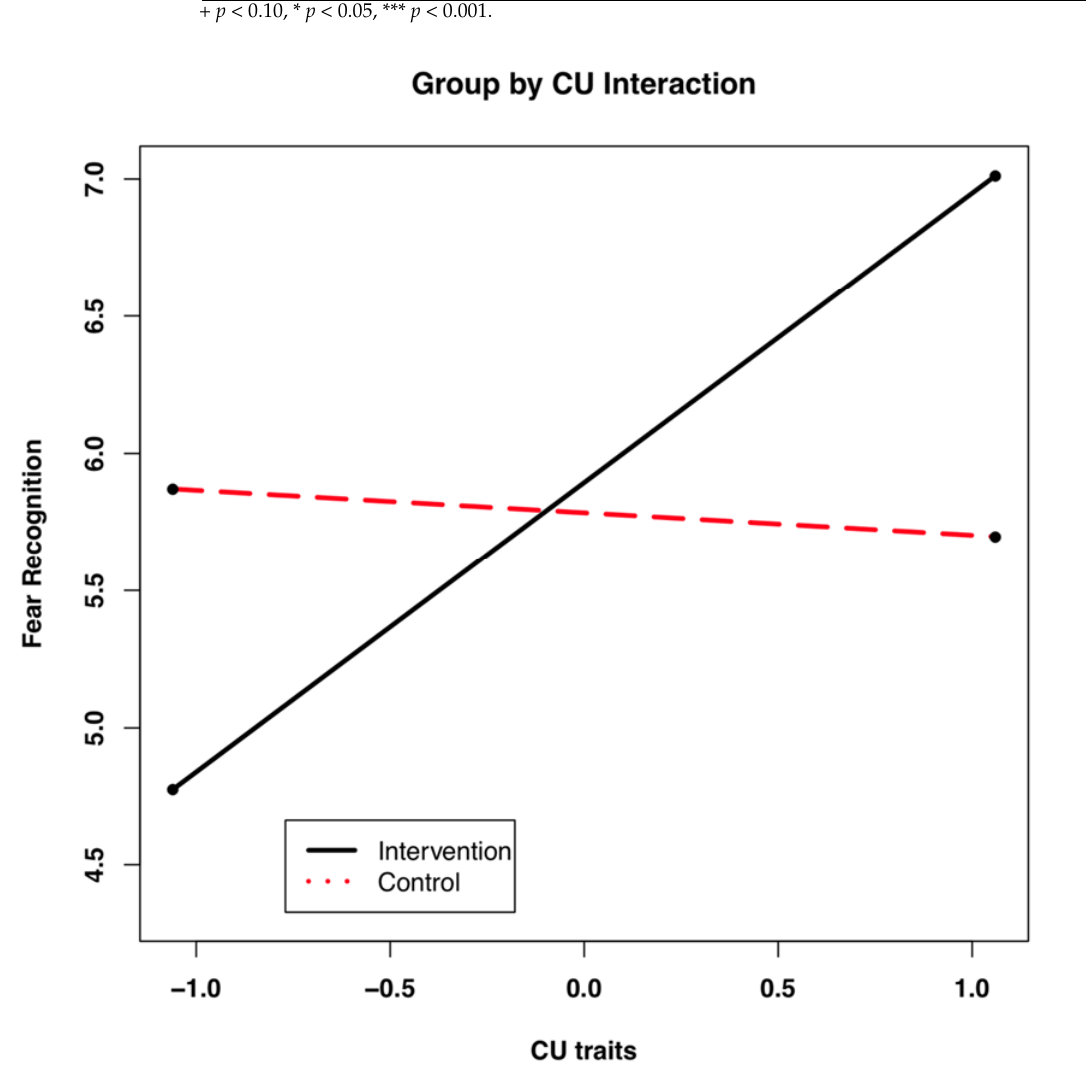
Figure 6. Wave 1 Group by CU Traits Interaction